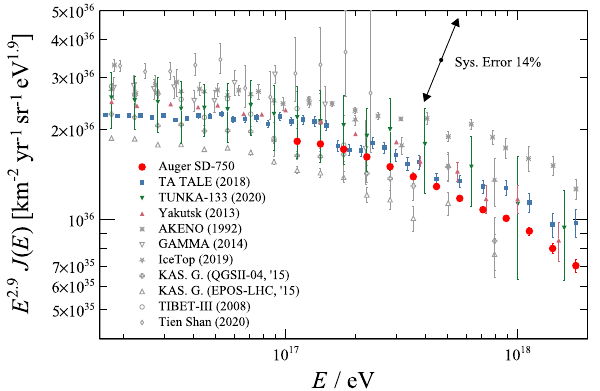
Fig. 18 SD-750spectrum(solidredcircles)nearthesecondkneealong with the measurements from Akeno [44], GAMMA [45], IceTop [9], KASCADE-Grande [46], TALE [10], Tien Shan [47], Tibet-III [48], Tunka-133 [11], Yakutsk [49]. The experiments that set their energy scale using calorimetric observations are indicated by solid colored markers while those with an energy scale based entirely on simulations are shown by gray markers